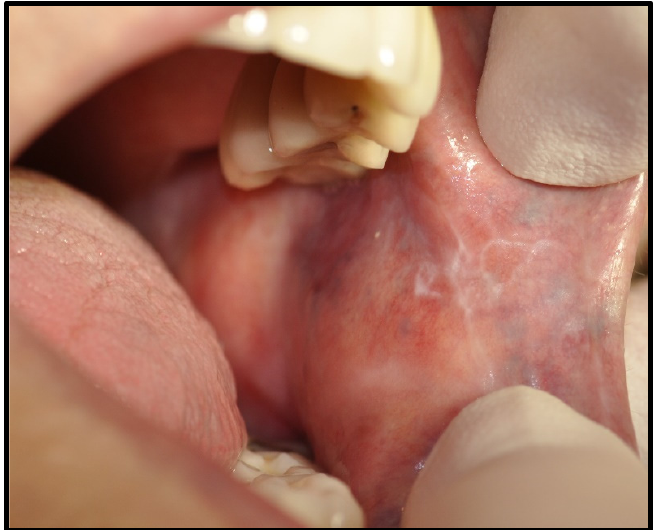
Figure 1. irLichenoid reaction. The patient, on pembrolizumab, presented with oral pain, mild burn- ing/itching, dysphagia, and di ffi culty in cleaning teeth. White striae are seen on the buccal mucosa.